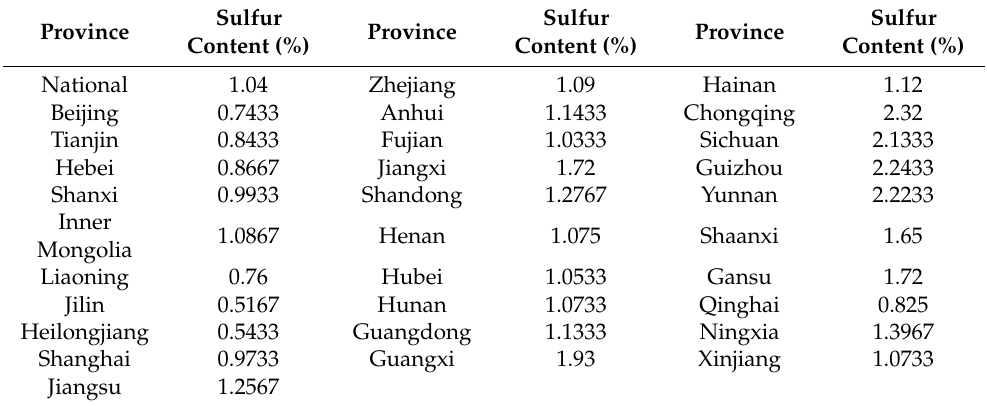
Table 3. Sulfur content and SO 2 emission factors of commercial coal for provinces and cities in